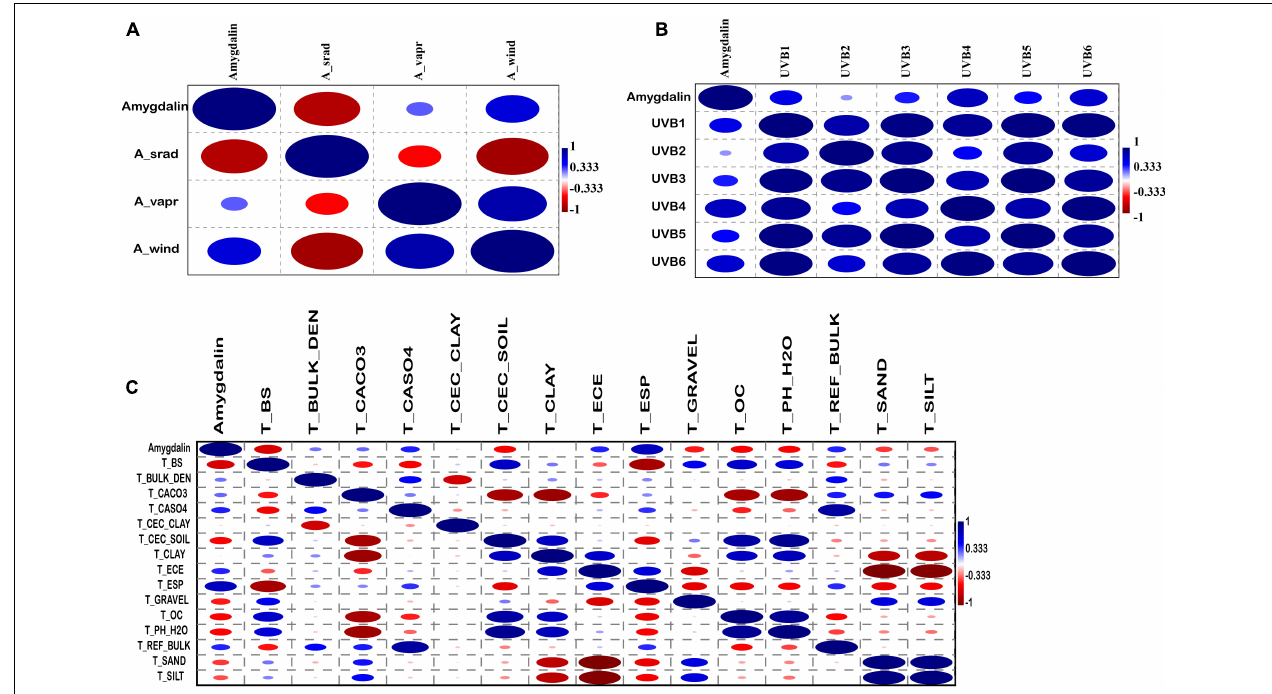
FIGURE 5 | Correlation coefficient between amygdalin content and 3 annual climate factor datasets (A_Srad, annual mean solar radiation; A_Vapr, annual mean water vapor pressure; A_Wind, annual mean wind speed). (A) Correlation coefficient between amygdalin content and six UV-B radiation datasets. (B) Correlation coefficient between 15 soil variables and amygdalin content. (C) The correlation coefficients ranged from 1 (blue, positive) to -1 (red,